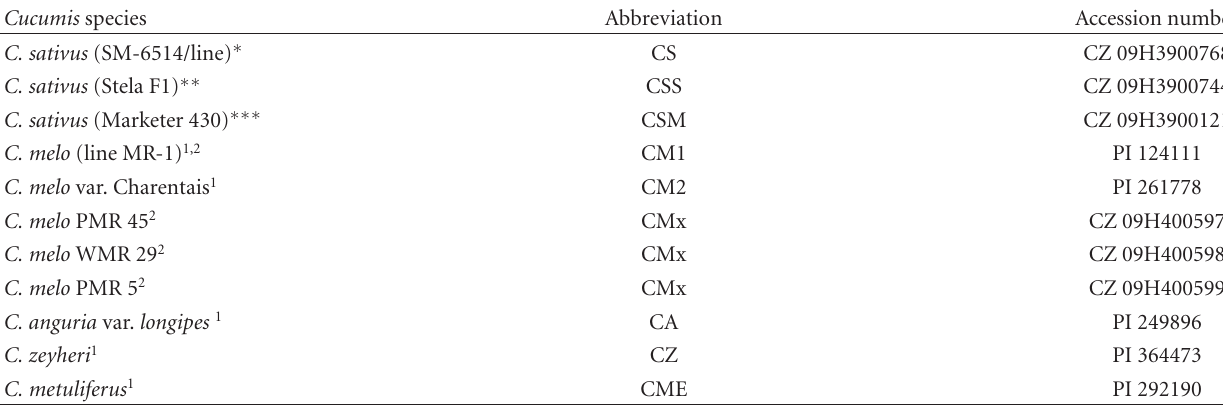
Table 1: Cucumis species, abbreviations, and accession numbers used in this